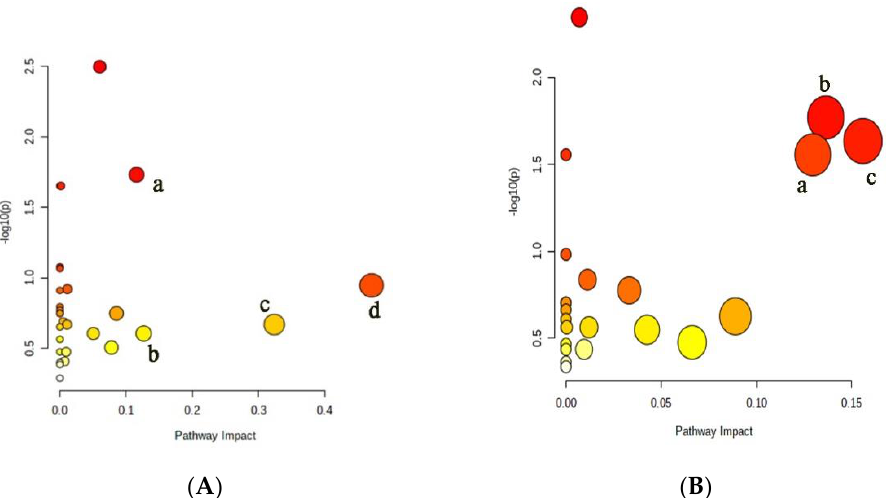
Figure 4. Analysis of metabolic pathways in xylem and phloem of cucumber. ( A ) Differential metabolite metabolic pathways in xylem: a. tricarboxylic acid cycle; b. glycolysis; c. alanine, aspartate and glutamate metabolism; d. phenylalanine metabolism; ( B ) differential metabolite metabolic pathways in phloem: a. metabolism of alanine, aspartate and glutamate; b. γ - aminobutyric acid metabolism; c. tricarboxylic acid cycle.